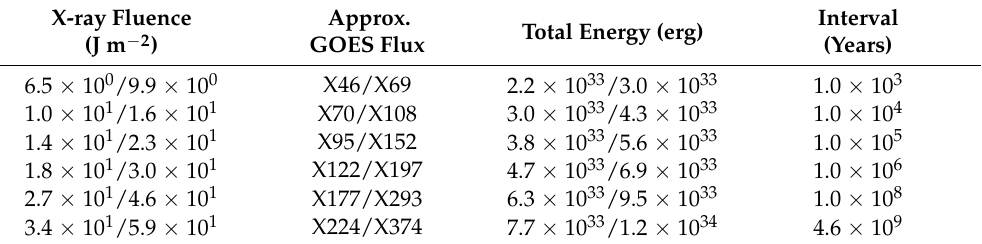
Table 4. Predicted flare sizes as a function of flare intervals (gamma function